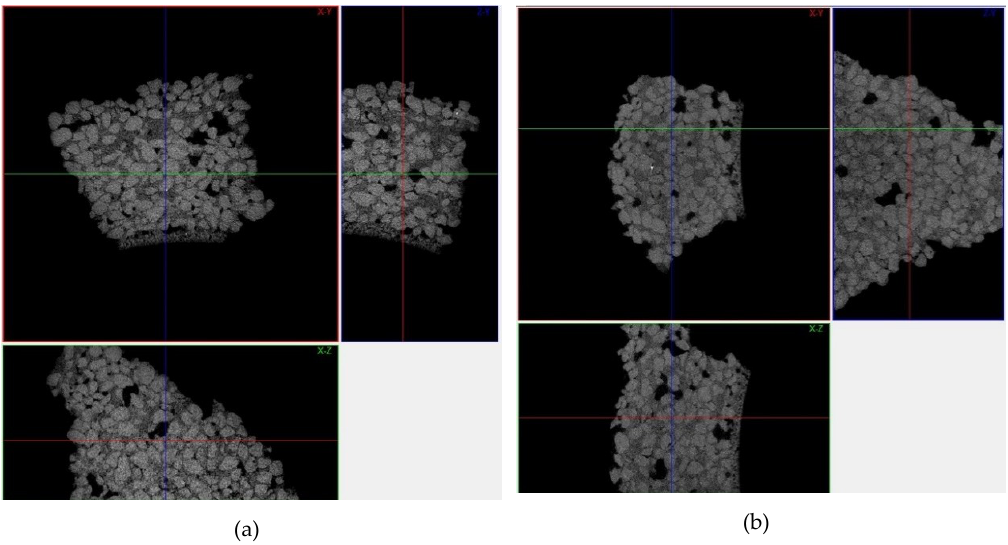
Figure 4. Ceramic mold sample tomograms with the three cross-sections shown in the XY, YZ, and XZ axes for ( a ) Sample Q1 and ( b ) Sample Q2.